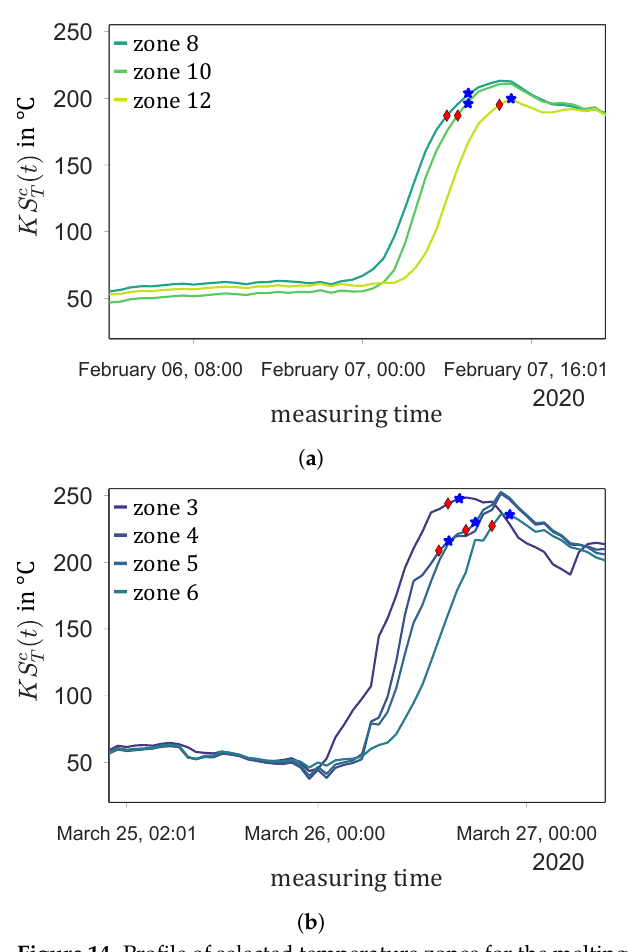
Figure 14. Profile of selected temperature zones for the melting process in ( a ) February and ( b ) March 2020 with labels for the time of stable sigmoid estimation (red diamond) and the calculated end of the melting process (blue